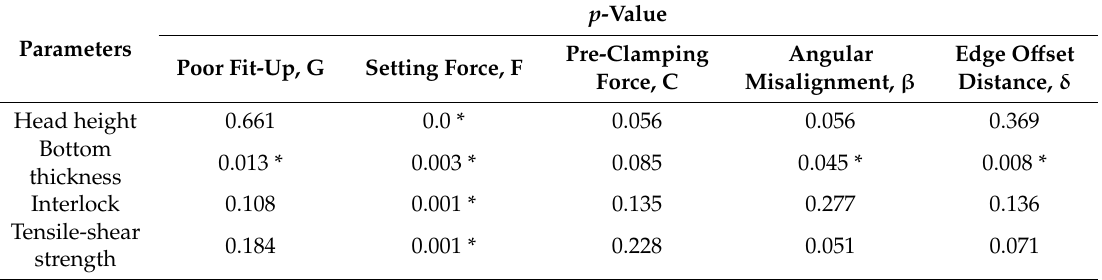
Table 4. AVOVA results for the experiments with Table